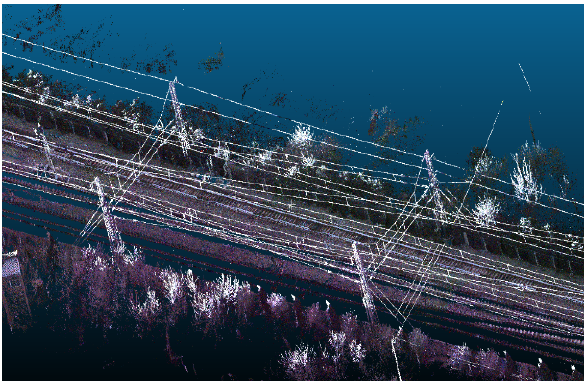
Figure 2. Railway power line point cloud data